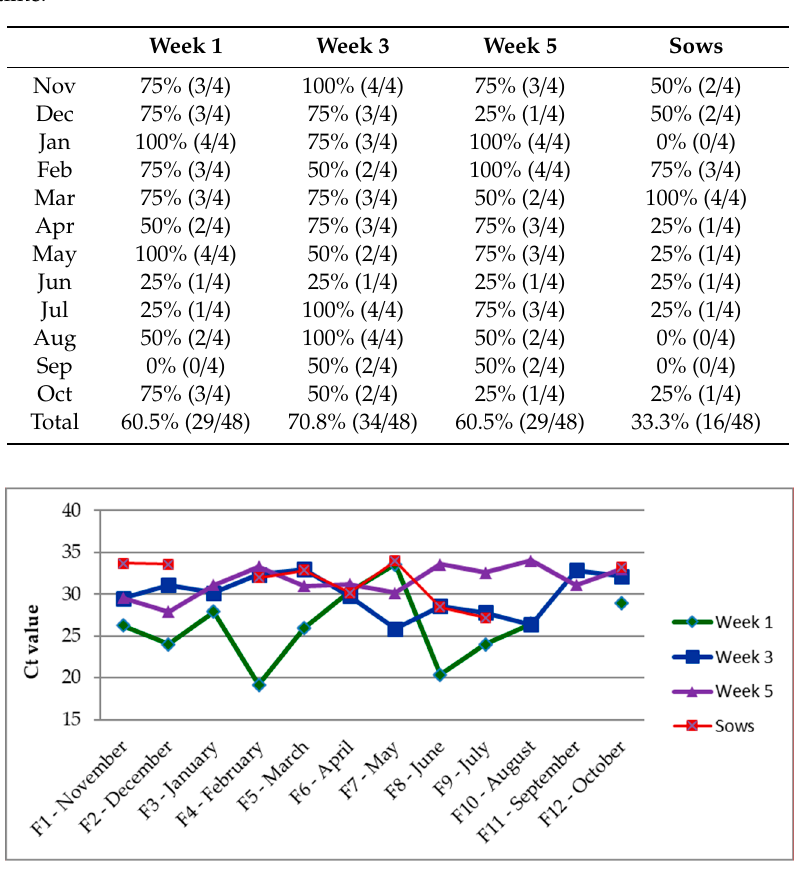
Table 1. Prevalence of swine influenza A viruses (swIAV) positive litters / pens and sows at each sampling time.